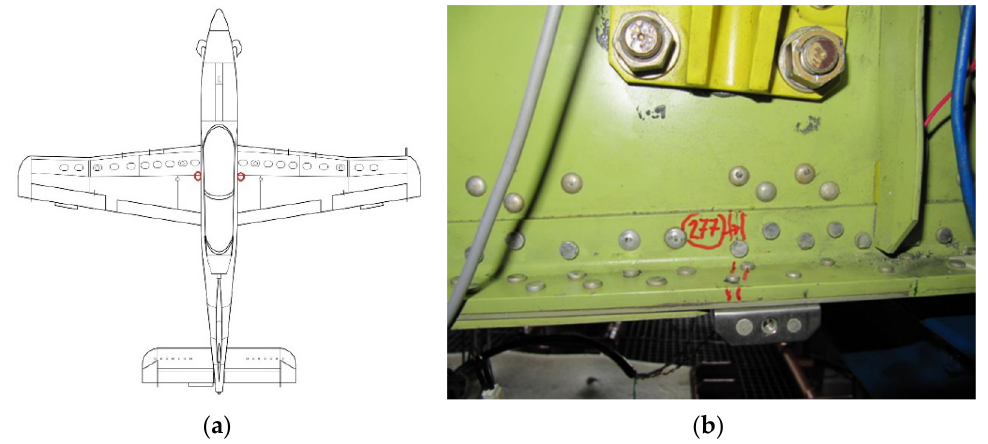
Figure 3. Location of the CP2 critical point on the wing main spar. ( a ) General location in the structure (LHS and RHS); ( b ) actual damage found during the test (damage No. 277 RHS) found after 21,000 SFHs.